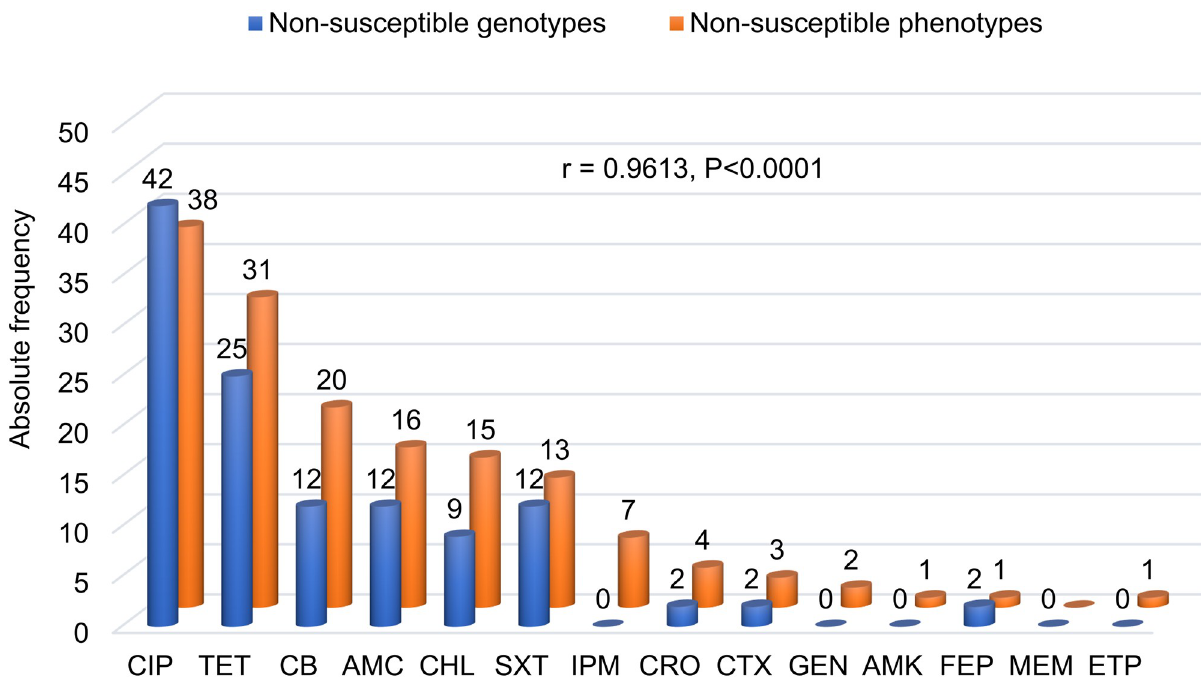
Fig 2. Schematic representation of the overall correlation between predicted AMR genotypes and observed AMR phenotypes of 77 Salmonella isolates. The figure shows the number of genotypically and phenotypically non-susceptible isolates to each tested antibiotic. Antibiotic abbreviations: ciprofloxacin (CIP), tetracycline (TET), carbenicillin (CB), amoxicillin-clavulanic acid (AMC), chloramphenicol (CHL), trimethoprim- sulfamethoxazole (SXT), imipenem (IMP), ceftriaxone (CRO), cefotaxime (CTX), gentamycin (GEN), amikacin (AMK), cefepime (FEP), meropenem (MEM), ertapenem